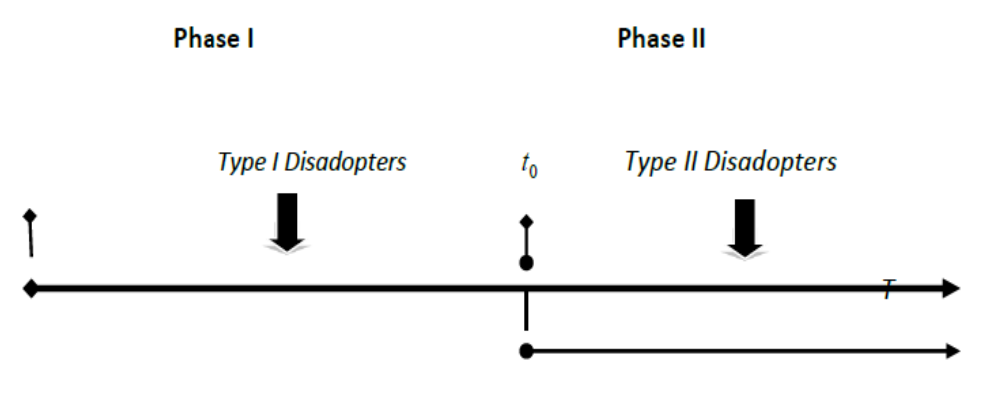
Fig. 1. Two phase disadoption